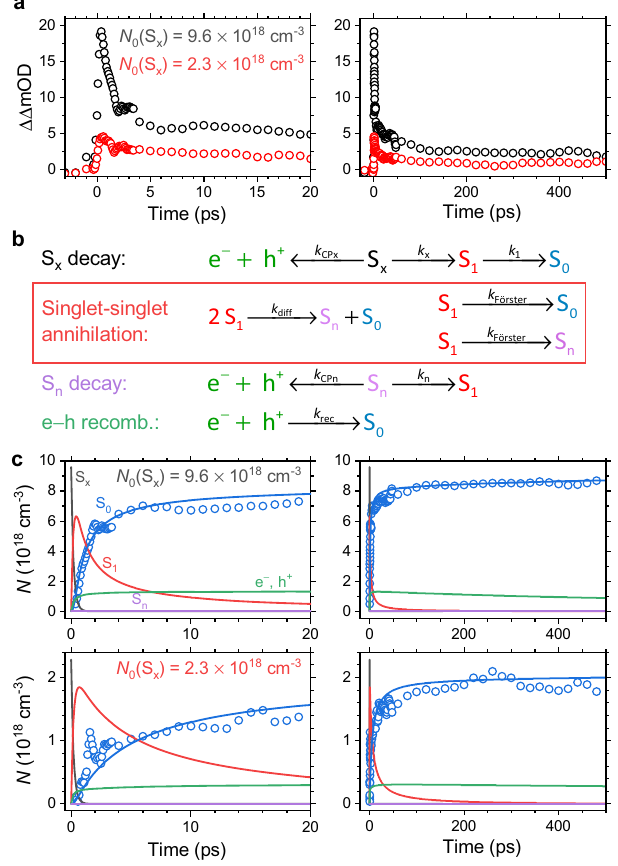
Fig. 7 Kinetic modelling of the TrCD kinetics of a 241 nm thin c-PFBT fi lm. a TrCD decay kinetics (averaged over the TrCD peak region 460 − 470 nm) for the initial S x exciton number densities N 0 (S x ) = 9.6 × 10 18 cm − 3 (black) and 2.3 × 10 18 cm − 3 (red). b Kinetic model for describing the population dynamics. c Results of the kinetic modelling for the initial S x exciton number densities 9.6 × 10 18 cm − 3 (top) and 2.3 × 10 18 cm − 3 (bottom), with the dynamics on short time scales (up to 20 ps) on the left side and long time scales (up to 500 ps) on the right side. Blue circles: Recovery of S 0 population as experimentally determined in the TrCD measurements with corresponding blue fi t lines obtained from the kinetic model; black, red, green and violet lines: number density of the as obtained from the kinetic Transient CD and transient absorption mapping . The high signal-to-noise ratio of the transient TA and TrCD signals also allows for a time-resolved point-by-point mapping of the c-PFBT thin fi lm. The spatial resolution is de fi ned by the probe beam diameter, which is currently 50 μ m. Figure 6 shows an example of such a spatial mapping for an area of about 1 mm 2 area (roughly 400 points) at the time delay t = 1 ps. Panel a contains TA spectra for right- and left-circularly polarised probing and the resulting TrCD spectrum averaged over the complete area. Transient absorption maps for LCP and RCP probing are presented in panels b − e. These were averaged over two different wavelength intervals: 296 − 313 nm (GSB, panels b and d) and 360 − 370 nm (ESA, panels c and e). In both cases, blue colours correspond to smaller Δ OD values and brown colours to larger ones. All the maps for LCP and RCP probing agree very well. Note that the GSB and ESA maps appear inverted because of the opposite sign